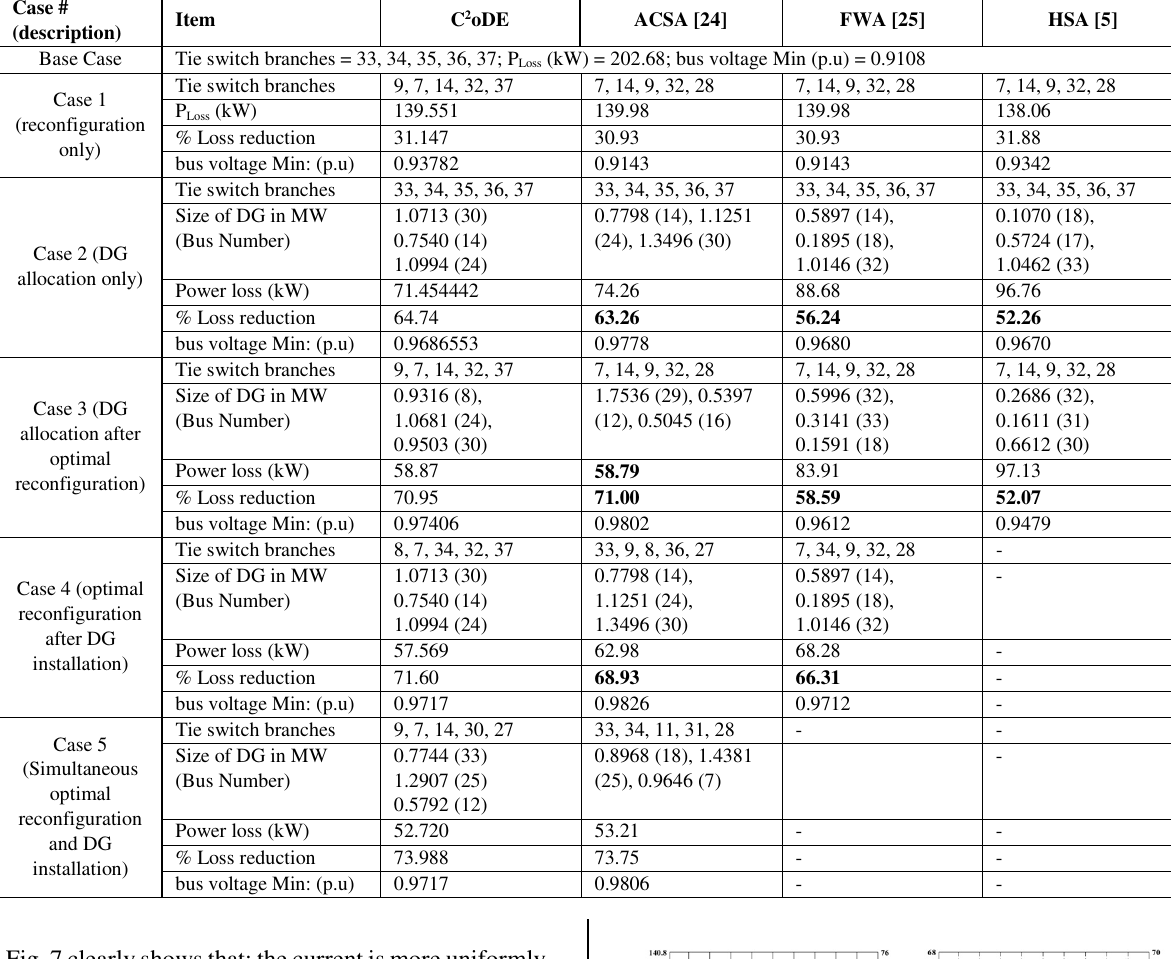
Table 4: Simulation Results of IEEE 33-Bus Distribution System